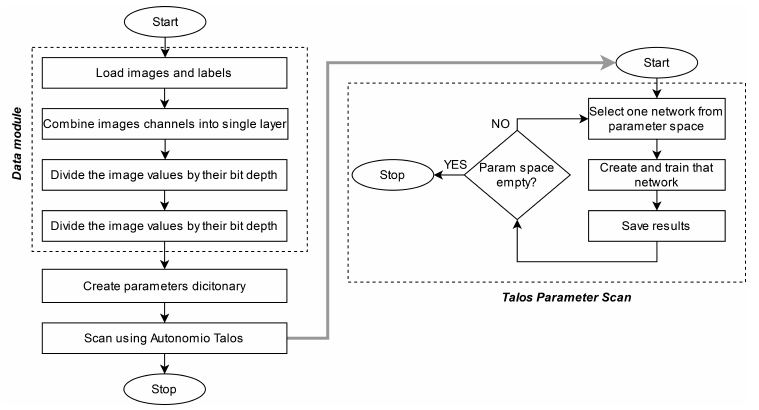
Figure 3. The description of the algorithm used for optimization of model hyperparameters. Table 1. A list of optimized hypermarameters of the developed